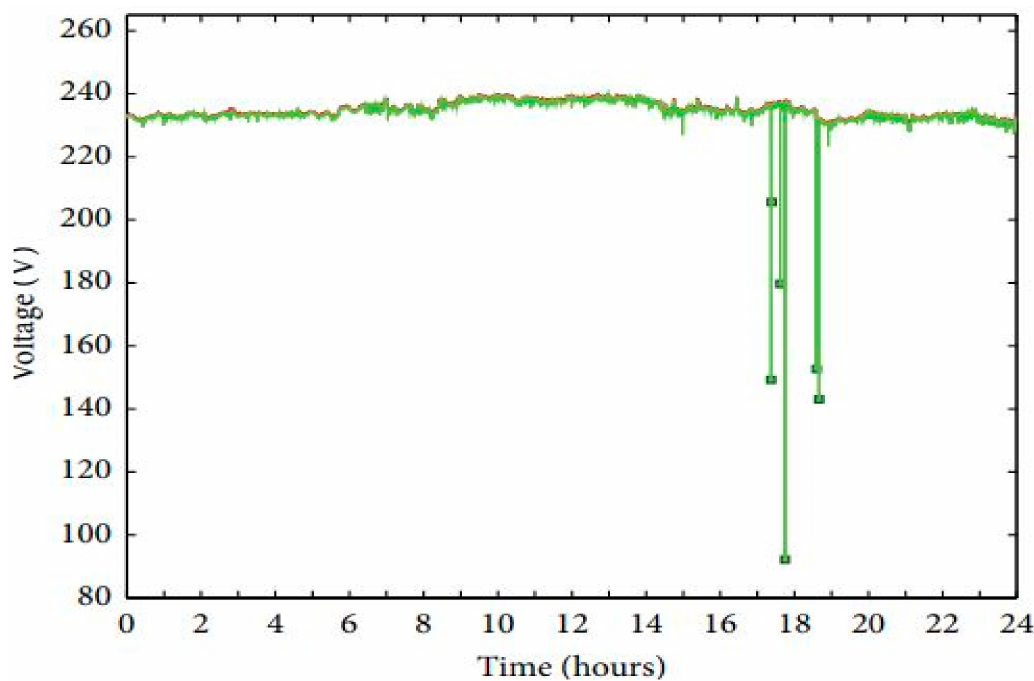
Figure 10. Voltage profile of the facility for 24 h. The green line shows the lowest voltages obtained, the large green dots indicate the voltage dips, the black line shows the medium voltages, and the red line represents the maximum voltages [62].